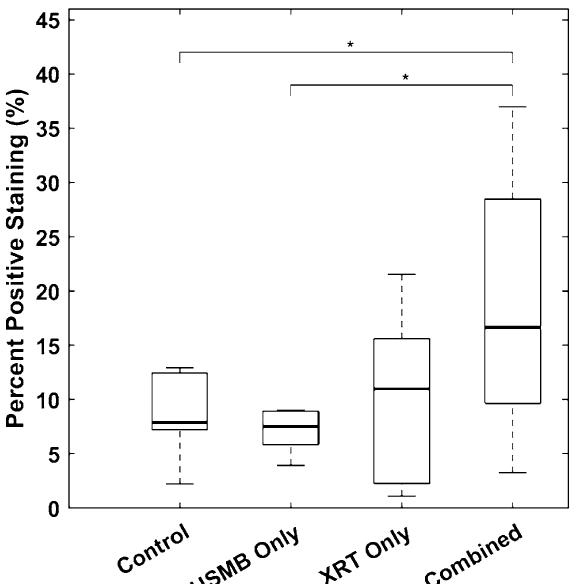
Figure 7. The percent positive staining for untreated controls, USMB-only, XRT-only, and combined treatment groups respectively. Boxplots show groupwise median (bold line), interquartile range (box), and standard deviation (dashed lines). A one-way analysis of variance demonstrated a statistically significant difference between group means (n = 30, df = 26, p = 0.026). Group-wise multiple comparisons are shown in horizontal lines. The mean differences in percent positive staining between combined and untreated controls, USMB-alone, and XRT-alone groups were 9.68% ( p = 0.037, 95% CI: 0.47–18.9%), 11.3% ( p = 0.036, 95% CI: 0.62–22.0%),